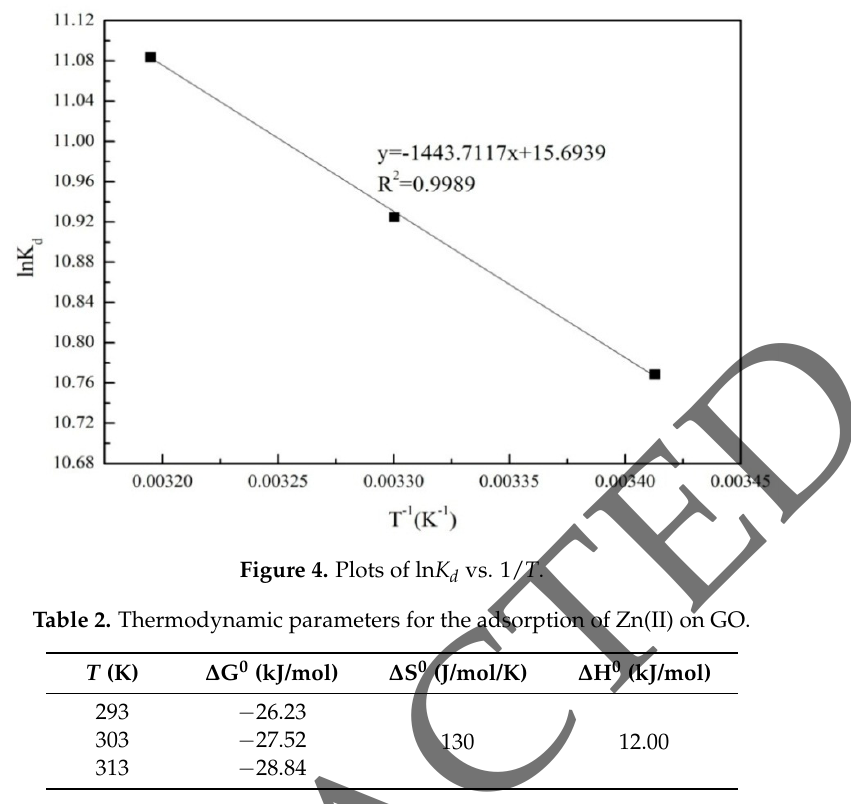
Figure 4. Plots of ln K d vs. 1/ T . Table 2. Thermodynamic parameters for the adsorption of Zn(II) on GO.